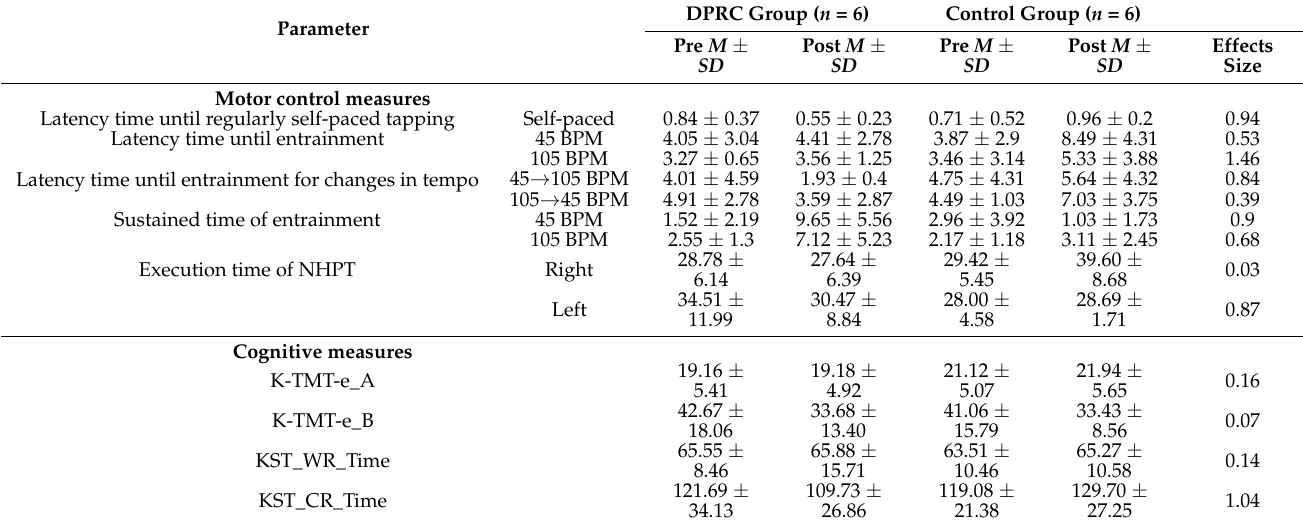
Table 4. Changes in motor control and cognitive measures for each